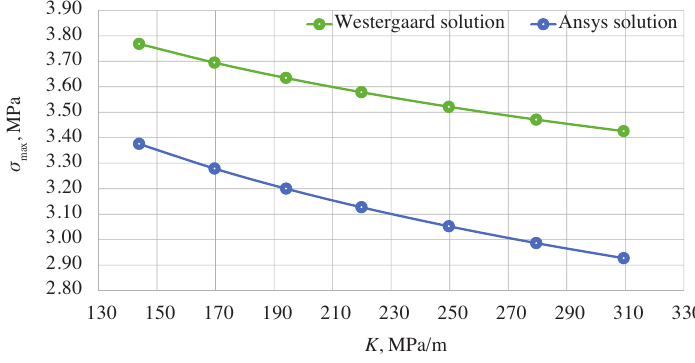
Figure 6. Variation of subgrade reaction modulus